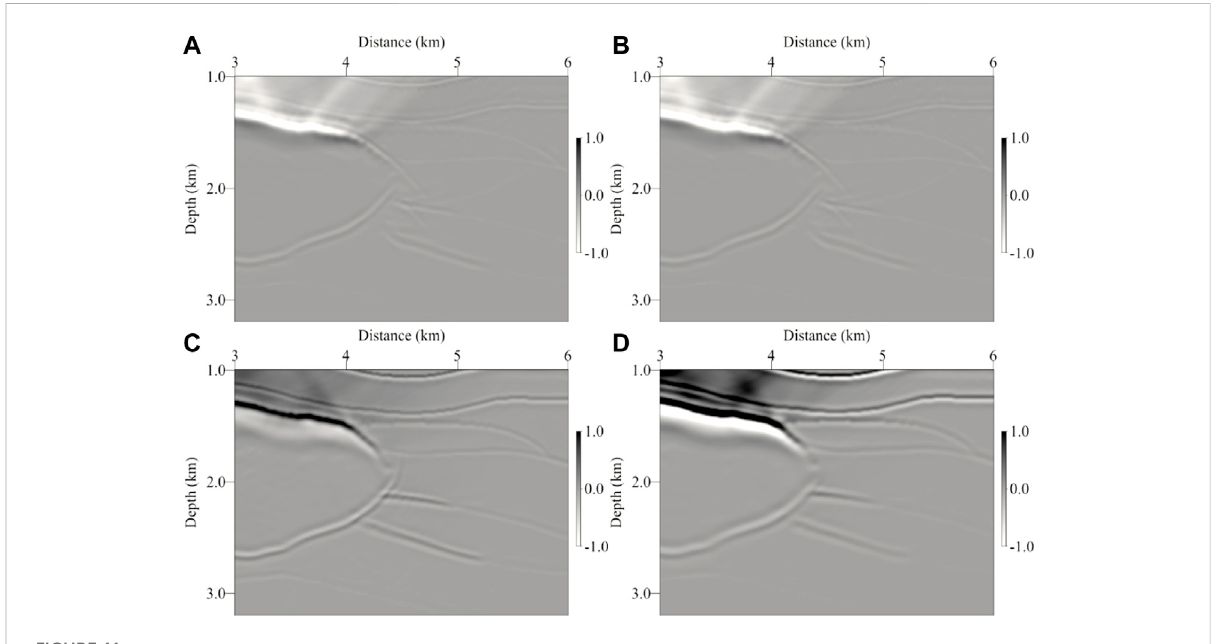
Zoomed views of RTM images shown in Figure 9. (A) Isotropic RTM image, (B) viscoacoustic RTM image, (C) VTI RTM image, and (D) viscoacoustic VTI RTM image. And the color scales of all the images are the same.